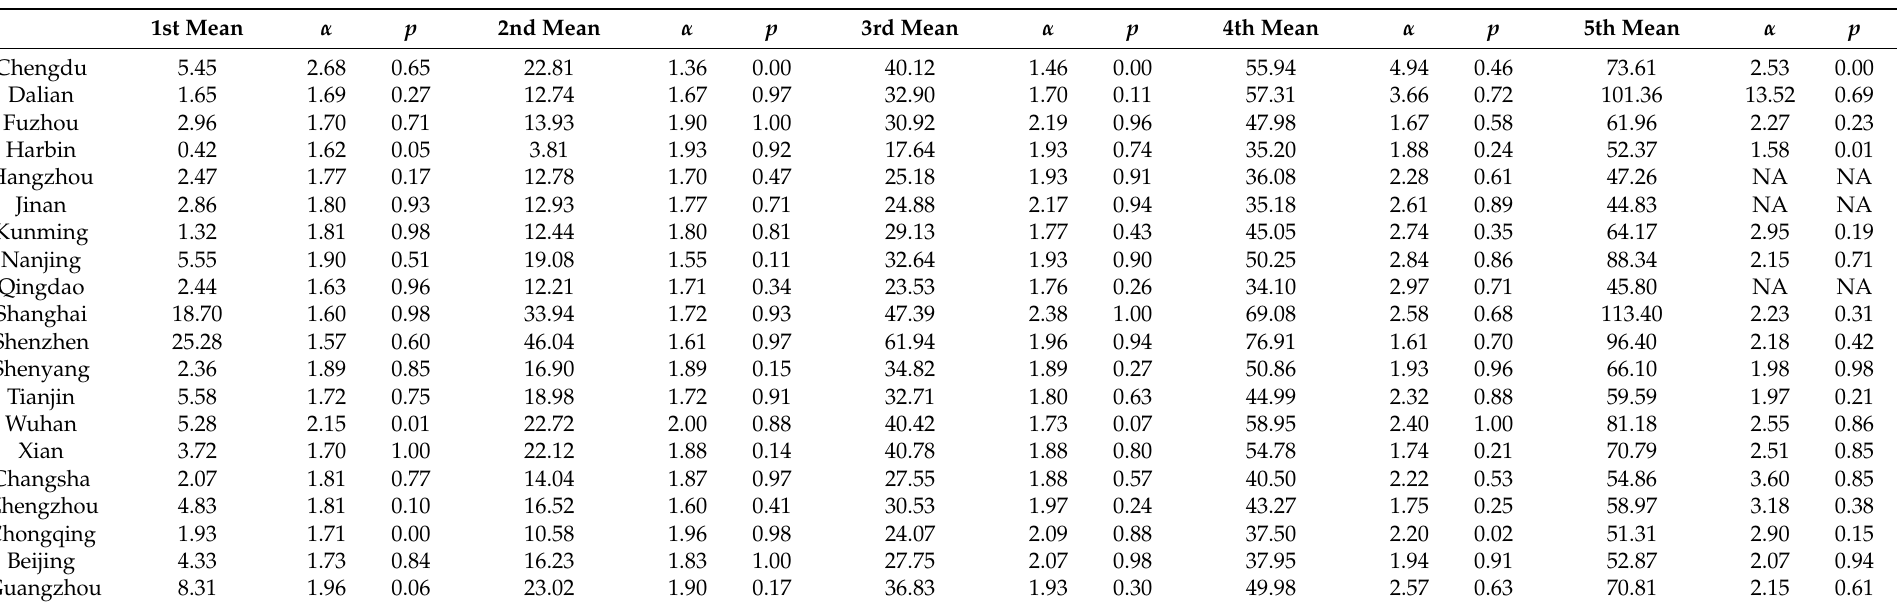
Table A1. The candidate cutoffs for spatial clustering of light pixels for hotspot detection and their corresponding power law metrics. (Note: NA: Not available; for most of cities, the number of scaling hierarchies of NTL image pixel lightness ≥ 5, meaning that there were at least 5 iteratively-averaged pixel values leading to an imbalanced ratio between dark-to-light pixels per city image. Among those five candidate cutoffs, the third one appeared to be the most suitable for urban hotspot delineation, as the almost related α values of hotspot areas were closest to 2 and with an acceptable p